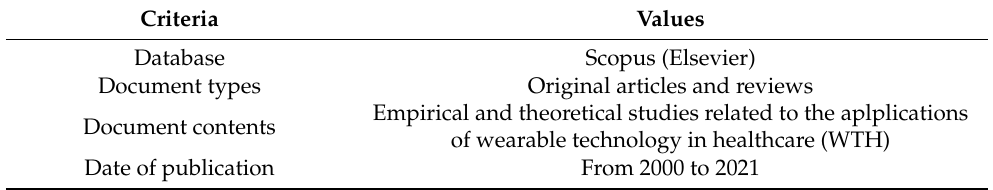
Table 2. Eligibility